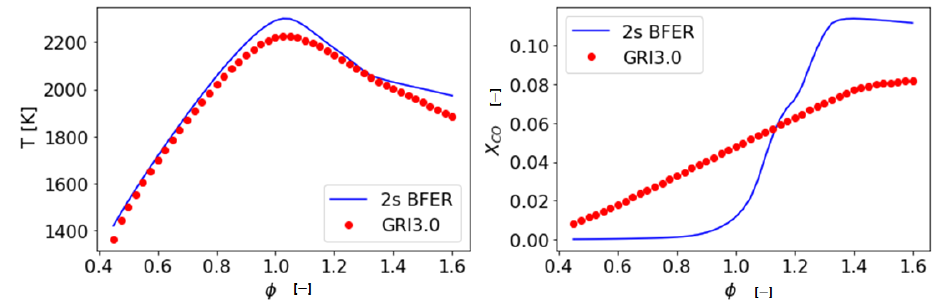
Figure 2. Adiabatic flame temperature ( left ) and CO mole fraction ( right ) as a function of the equivalence ratio for the conditions of Table 1 from freely propagating flamelet